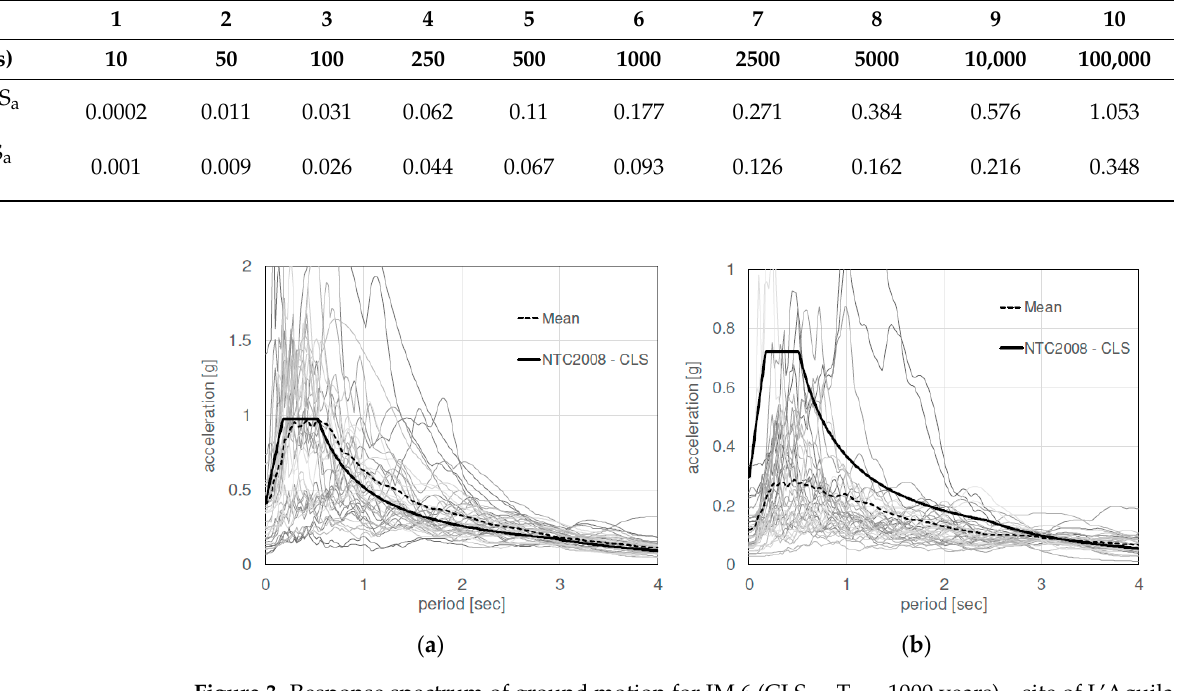
Figure 3. Response spectrum of ground motion for IM 6 (CLS − T R = 1000 years)—site of L’Aquila ( a ) and site of Napoli ( b ).